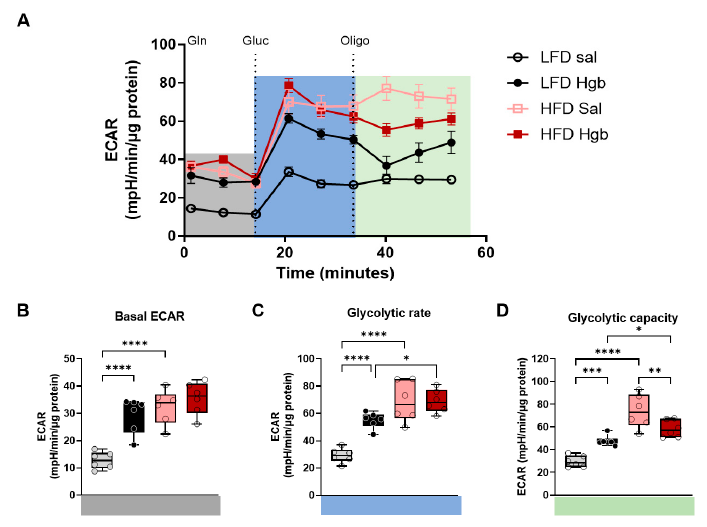
Figure 3. Bioenergetic shifts in response to iron in obese adipose tissue macrophages . Mice were fed low-fat (LFD) or high-fat (HFD) diets for 20 weeks. At week 19–20 of dietary challenge, mice were injected with either saline (Sal) or hemoglobin (Hgb). Adipose tissue macrophages (ATMs) were isolated using F4/80+ magnetic beads. ( A ) Extracellular acidification rate (ECAR) was measured by extracellular flux analysis in a modified mitochondrial stress test. Mitochondrial respiratory rates were calculated from extracellular flux analysis rates, as described in the Methods section. ( B ) Basal ECAR. ( C ) Glycolytic rate. ( D ) Glycolytic capcity. Statistics were performed using two-way ANOVA with Tukey’s multiple comparison post-hoc tests. * p < 0.05, ** p < 0.01, *** p < 0.001, **** p < 0.0001.